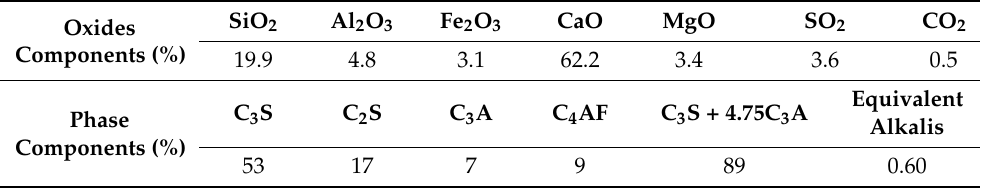
Table 1. Chemical composition of